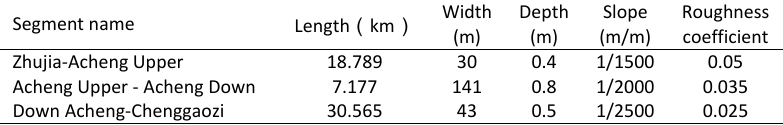
Fig. 5: Schematic diagram of Acheng District Section of Ashi River Table 2. Segments and hydrographic information of Acheng District Section for WASP model